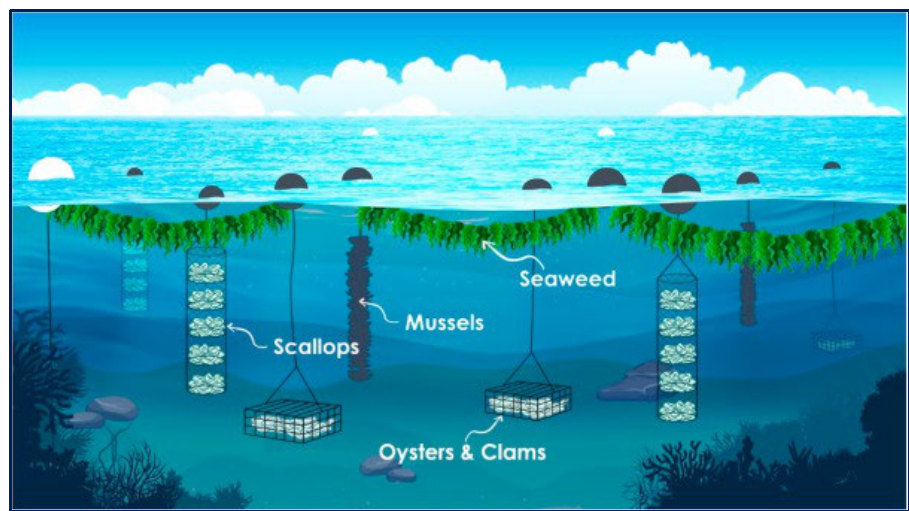
Figure 23. Shared farming Infrastructure. Reproduced with permission [44].